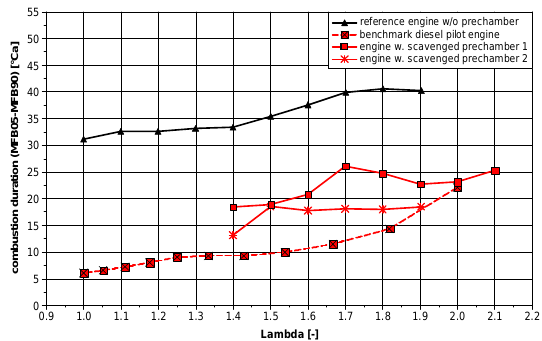
Fig. 16. Combustion durations for the operating point 1 (1400 rpm/50 Nm)